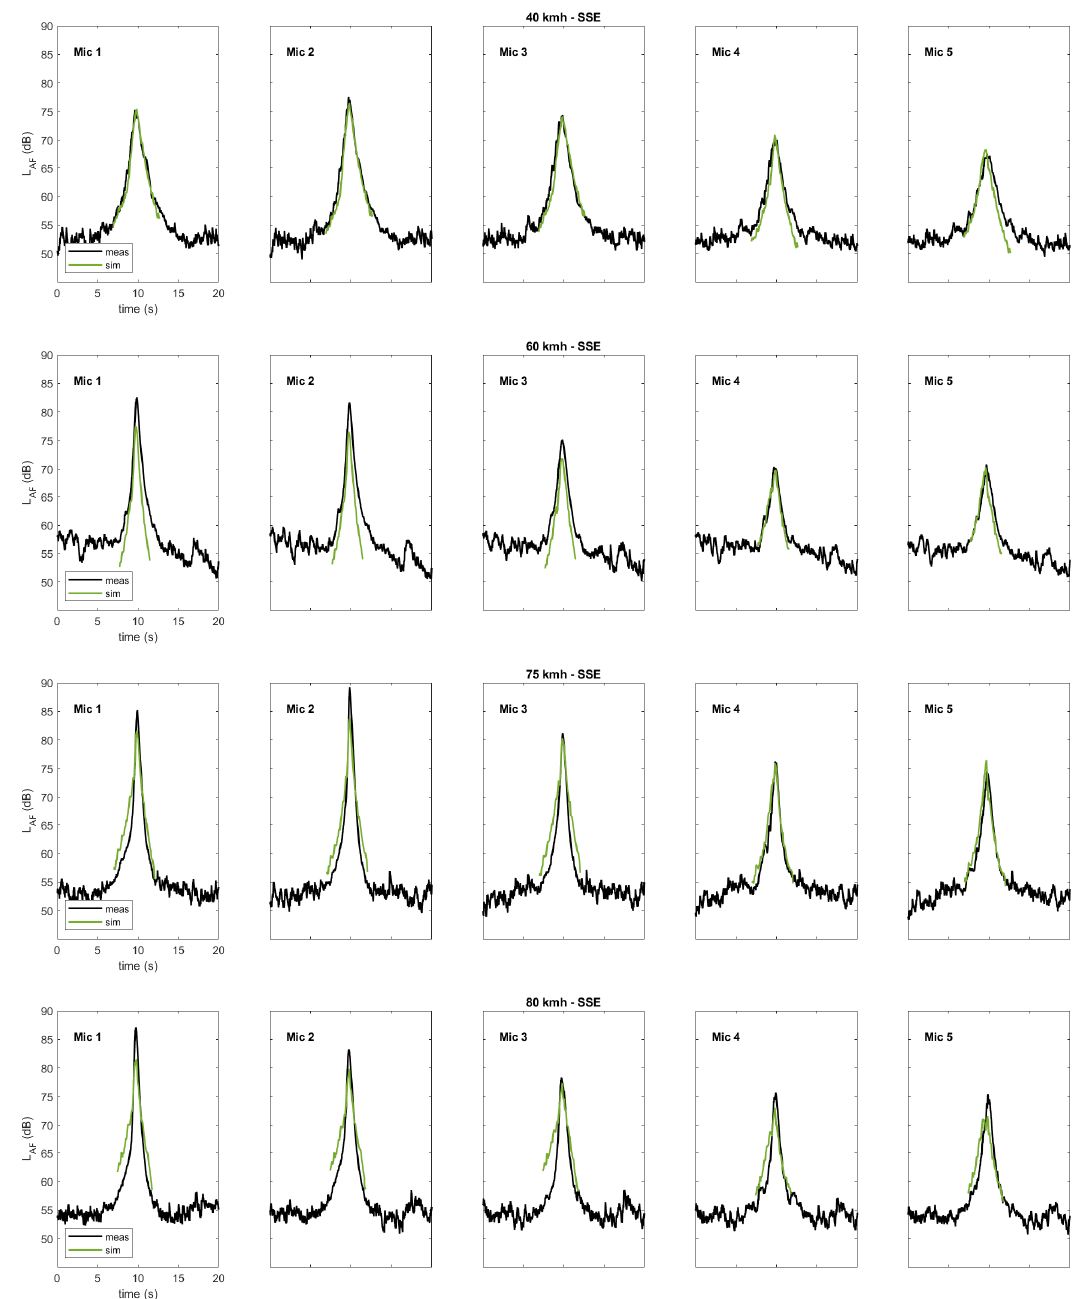
Figure A2. Comparison of measured vs. simulated A-weighted sound pressure level time histories for exemplary flights of the SSE multicopter at four different velocities, shown for all microphones.